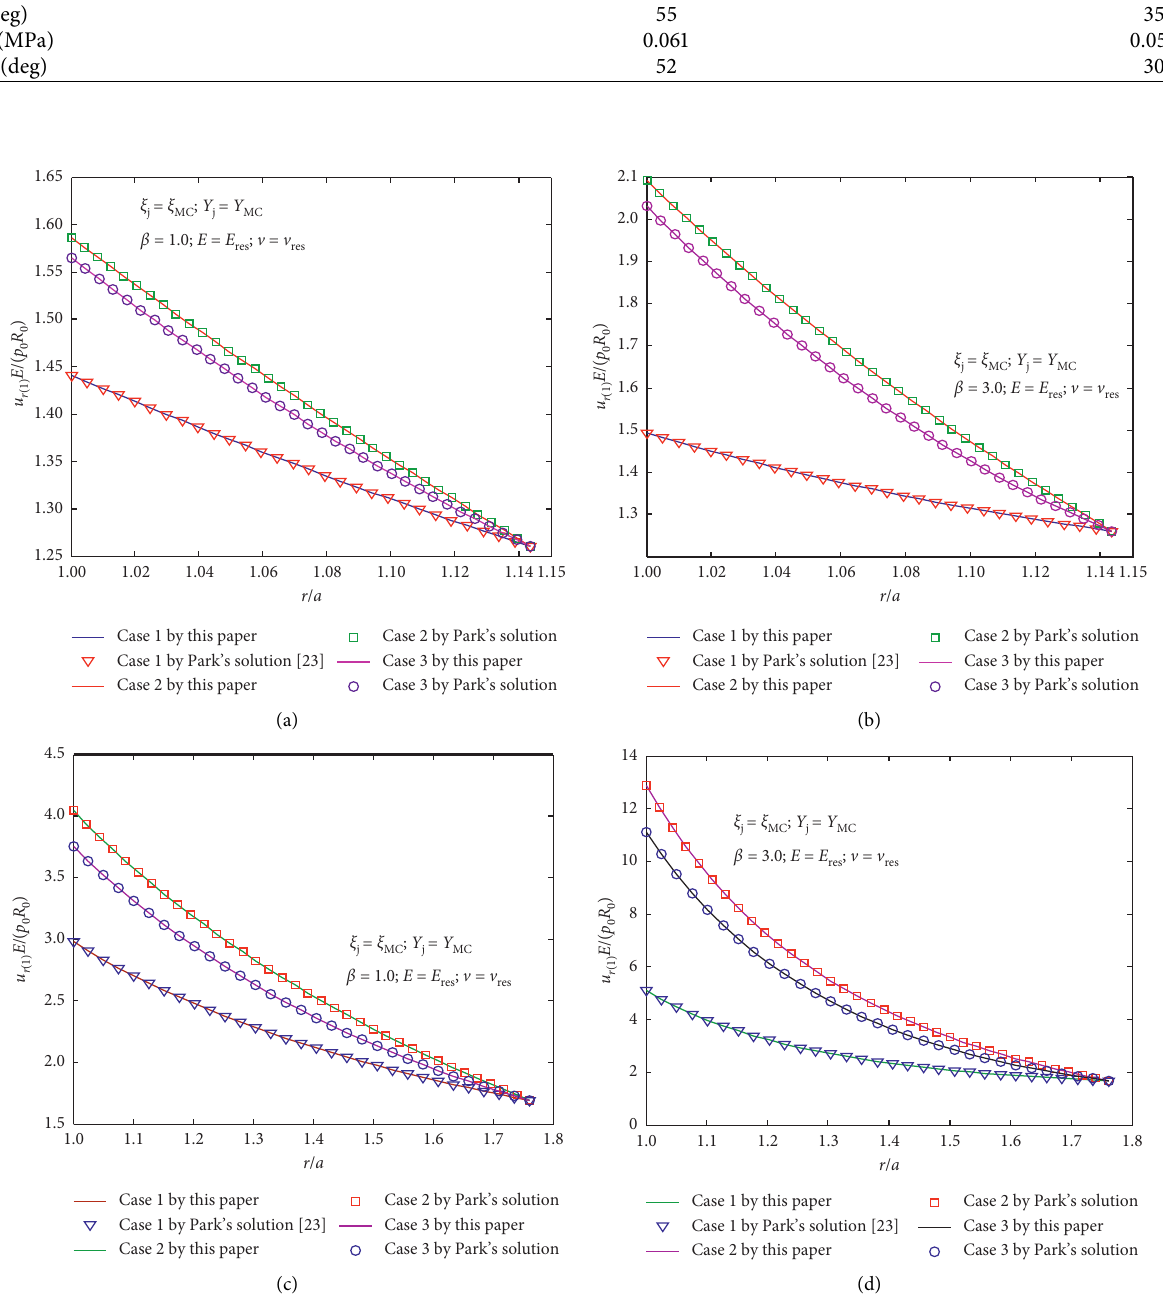
Figure 7: Comparison with the traditional solution. (a) Radial displacement (data: hard rock, β � 1.0). (b) Radial displacement (data: hard rock, β � 3.0). (c) Radial displacement (data: soft rock, β � 1.0). (d) Radial displacement (data: soft rock, β �